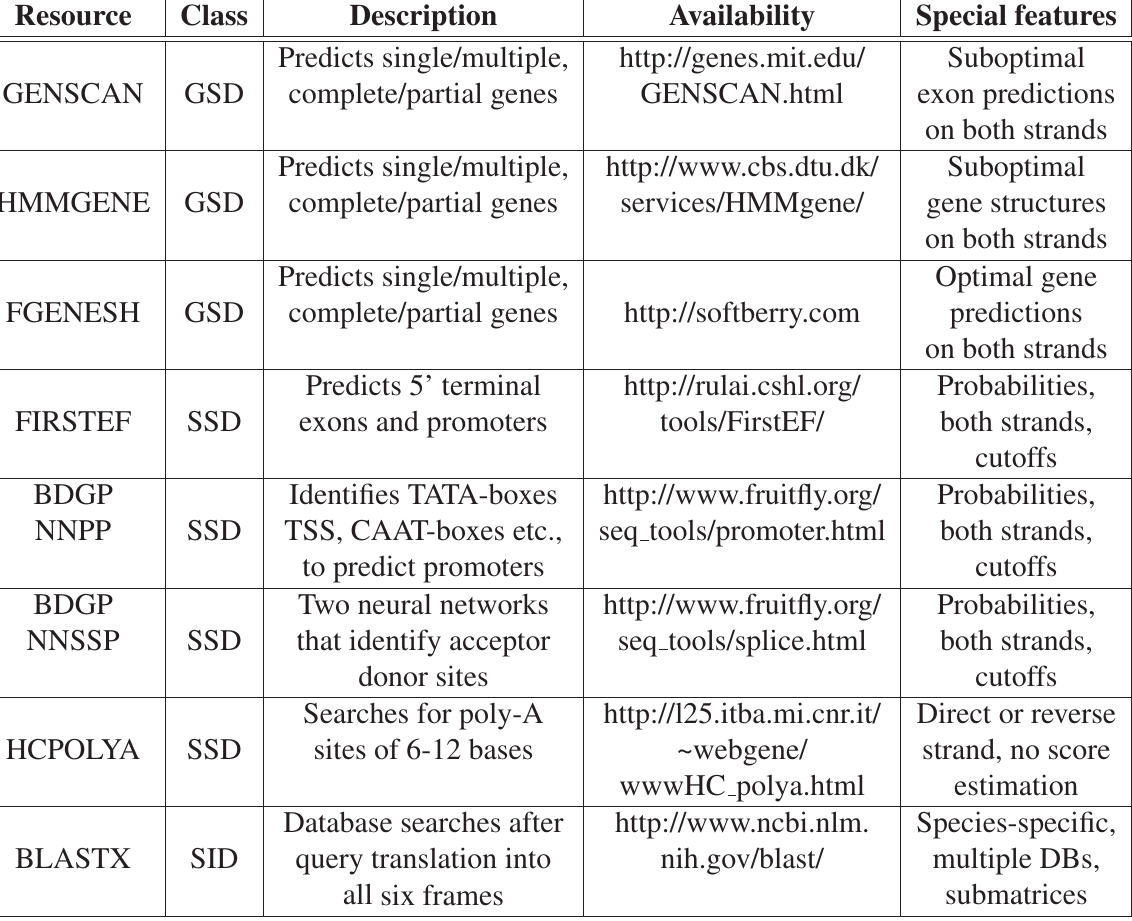
Table 1: List of the analysis tools representing GSD , SSD and SID classes that are incorporated in the implementation of the